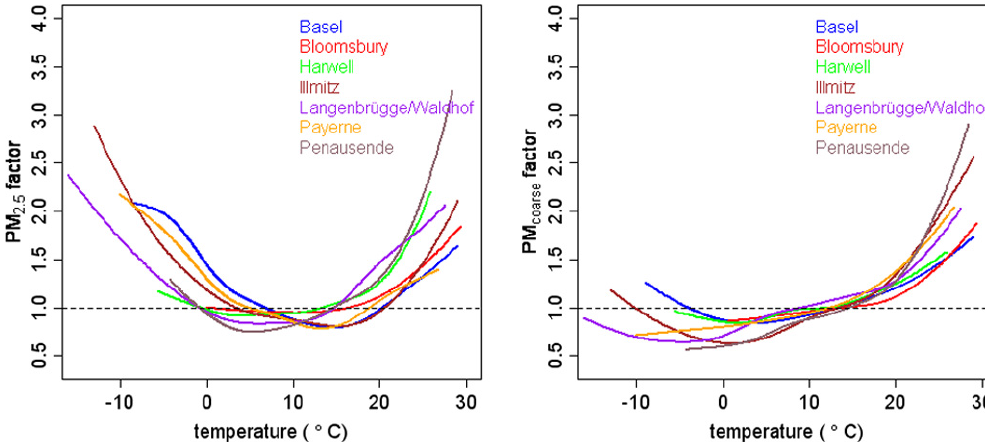
Fig. 2. PM 2 . 5 (left) and PM coarse (right) factors for temperature at all sites.